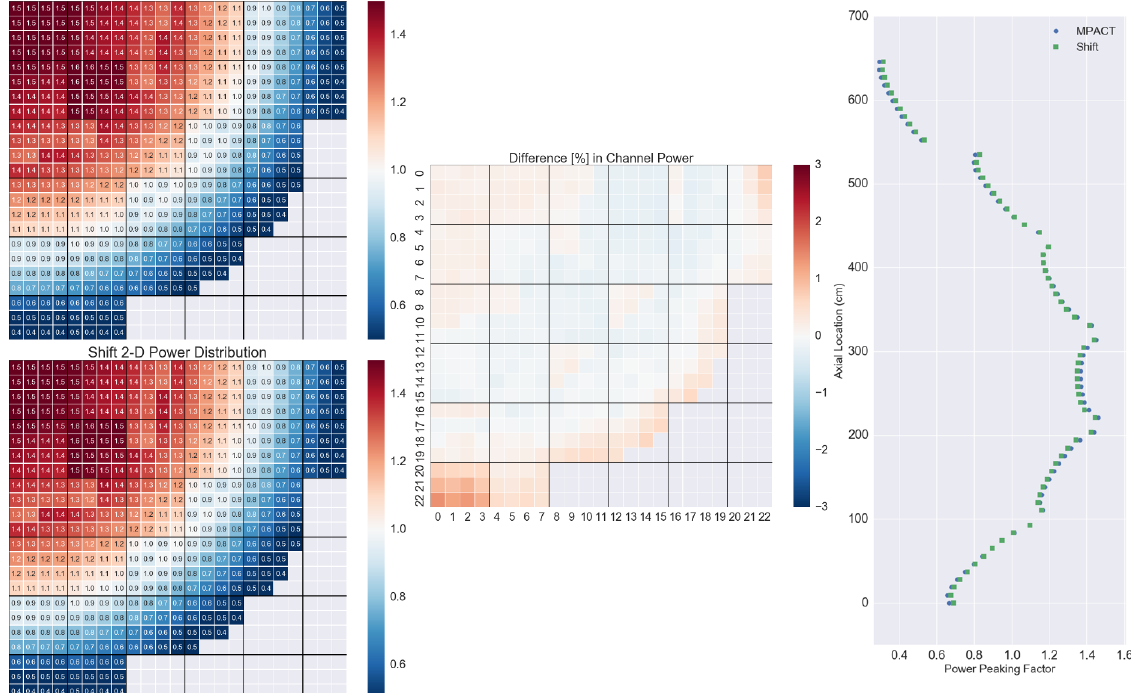
Figure 4. Radial and axial power distribution comparison for all control rods